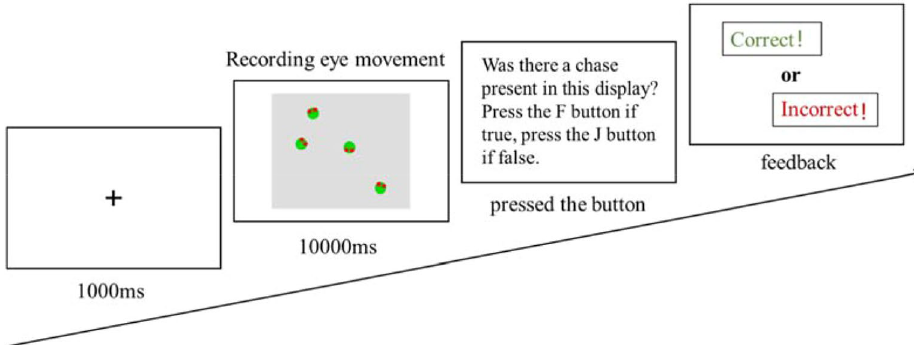
Figure 2. Graphical overview of the trial design.